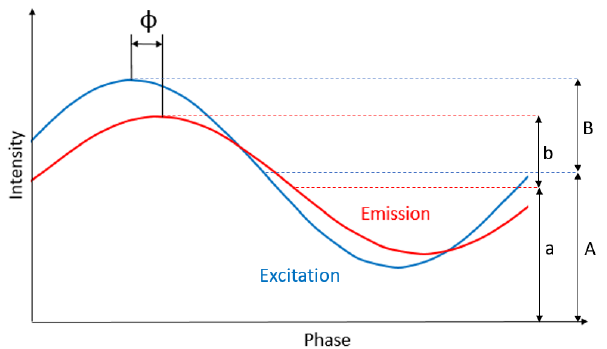
Figure 1. Illustration of the fluorescence decay characteristic. each of them tested for two excitation wavelengths (405 and 488 nm).